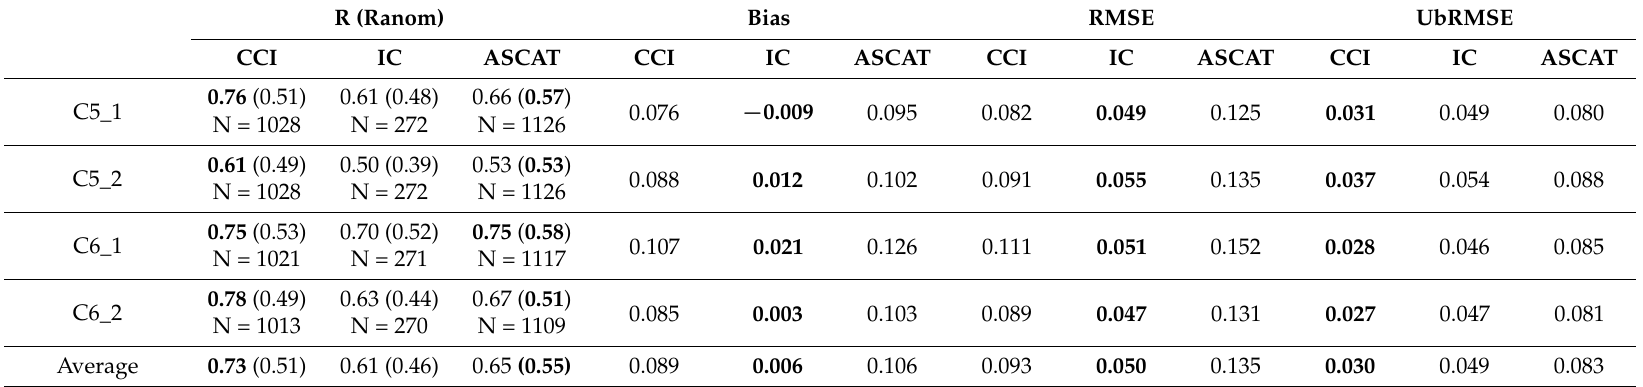
Table 7. Pearson correlation (R), Bias, RMSE, and UbRMSE calculated between SMOS-IC, ASCAT, and CCI SM retrievals and the Hermitage in situ measurements using all